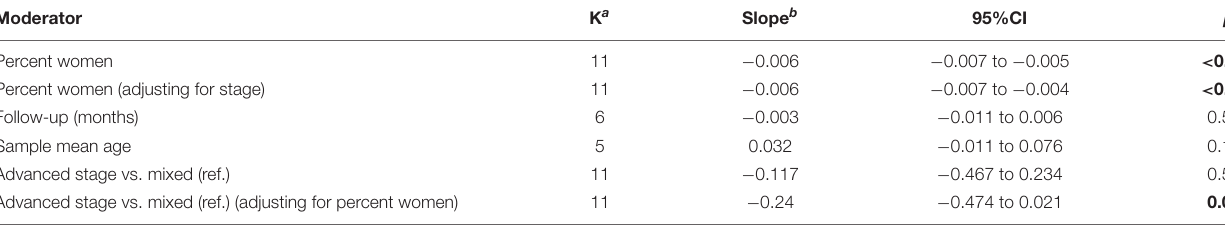
TABLE 3 | Exploring moderators of the association between poorer self-reported sleep and overall